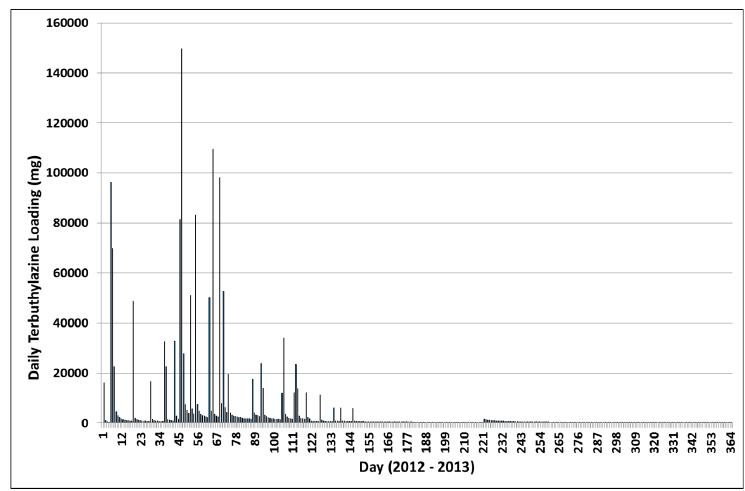
Figure 15. Year 1—daily loadings of terbuthylazine in the Rangitaiki River at the Rangitaiki flow gauge.